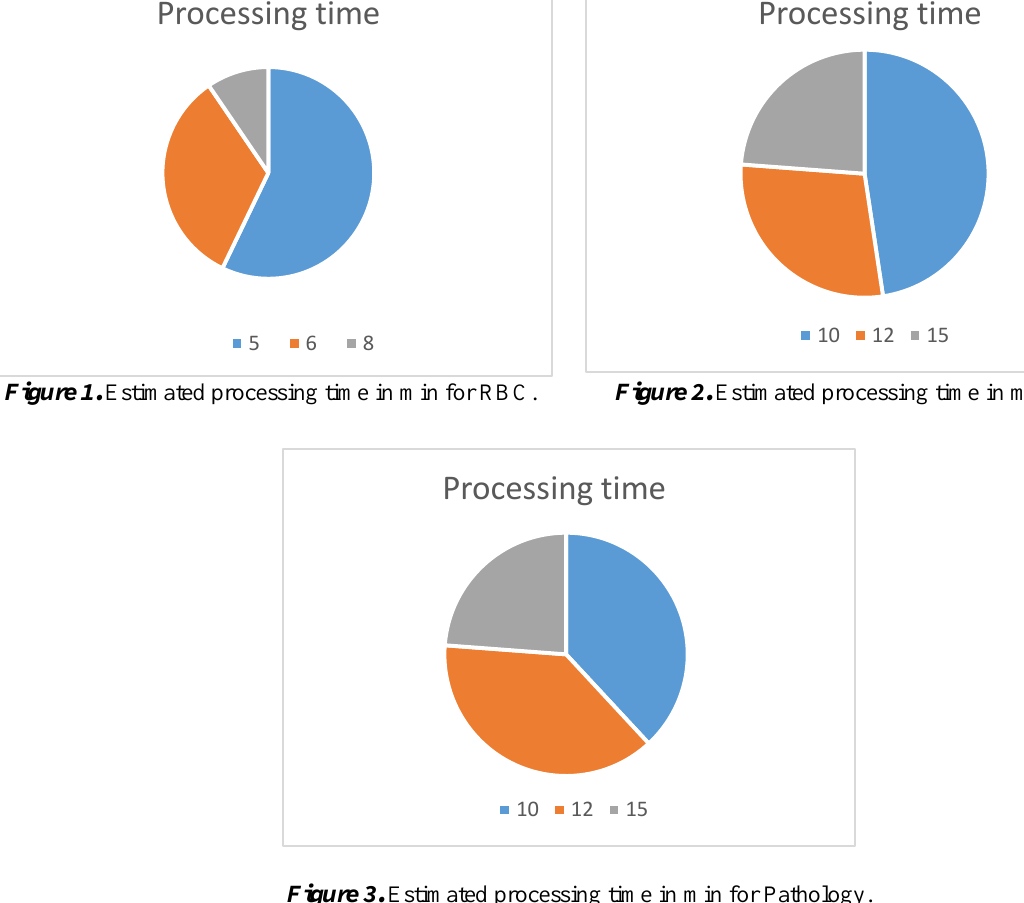
Figure 3. Estimated processing time in min for